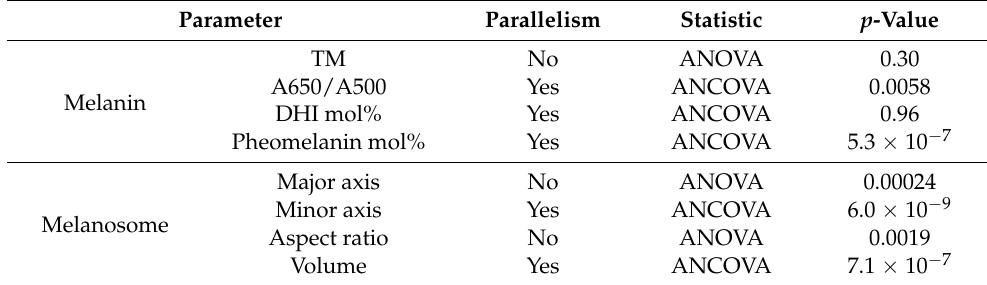
Table 2. Sex differences for melanin and melanosome parameters measured with ANCOVA or ANOVA. Parameter Parallelism Statistic p -Value TM No ANOVA 0.30 A650/A500 Yes ANCOVA 0.0058 Melanin DHI mol% Yes ANCOVA 0.96 Pheomelanin mol% Yes ANCOVA 5.3 × 10 − 7 Major axis No ANOVA 0.00024 Minor axis Yes ANCOVA 6.0 × 10 − 9 Melanosome Aspect ratio No ANOVA 0.0019 Volume Yes ANCOVA 7.1 × 10 −